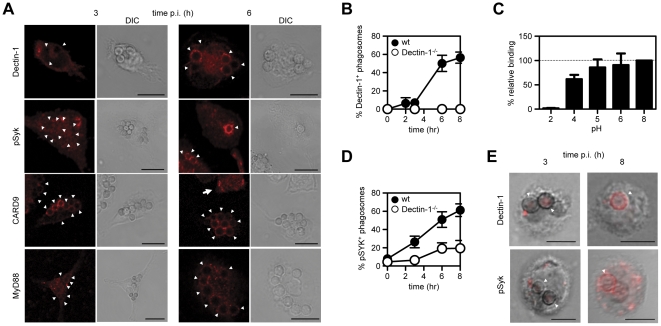
Phagolysosomes containing Aspergillus conidia acquire innate signalling components.(A) Immunofluorescent confocal analysis of phagosomes containing Aspergillus conidia at 3 and 6 hr after infection of thioglycollate-elicited macrophages, showing the recruitment of Dectin-1, phosphoSyk, CARD9 or MyD88. Scale bar indicates 10 µm. Arrowheads point to the location of conidia; bold arrow indicates cytoplasmic straining. (B) Kinetic analysis of the acquisition of Dectin-1 to the conidial phagosomes in wild type and Dectin-1−/− thioglycollate-elicited macrophages. (C) Flow cytometric analysis of the influence of pH on the ability of soluble Fc-Dectin-1 to bind to zymosan. (D) Kinetic analysis of the acquisition of phosphoSyk to conidial phagosome in wild type and Dectin-1−/− thioglycollate-elicited macrophages. (E) Immunofluorescent confocal analysis of BAL-cell phagosomes 3 and 8 hr after i.t. infection of mice with resting Aspergillus conidia, showing the recruitment of Dectin-1 and phosphoSyk (pSyk) to the conidial phagosome in vivo. Scale bar indicates 10 µm. Arrowheads point to the location of conidia. The data shown are representative of at least two independent experiments.